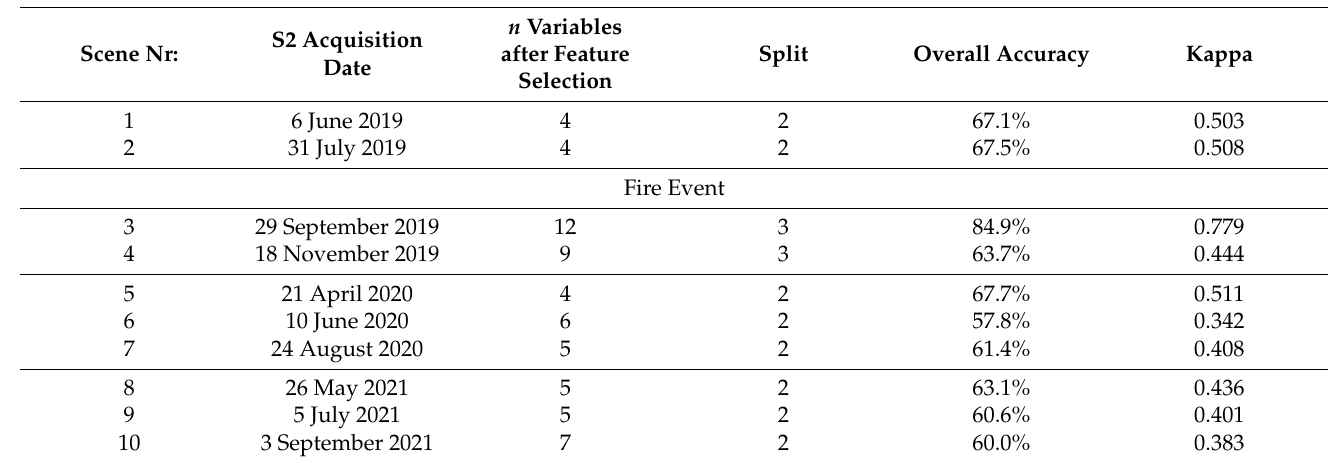
Table 4. BEST Random Forest models based on OOB results after Feature Selection using 23 Vegetation Indices from single Sentinel-2 data recording dates.